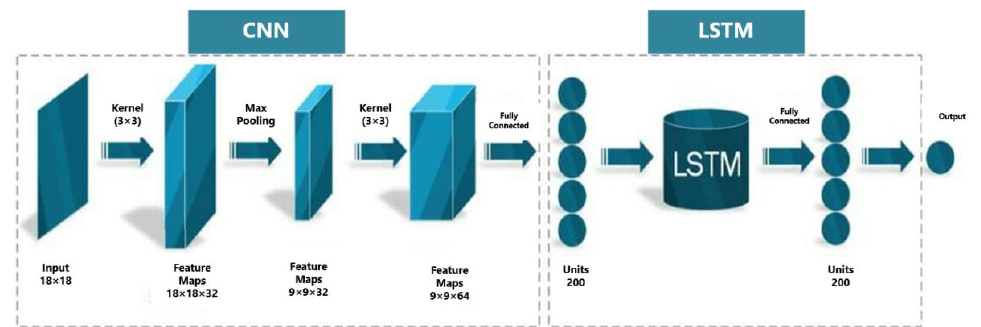
Figure 3. Flowchart of main steps.